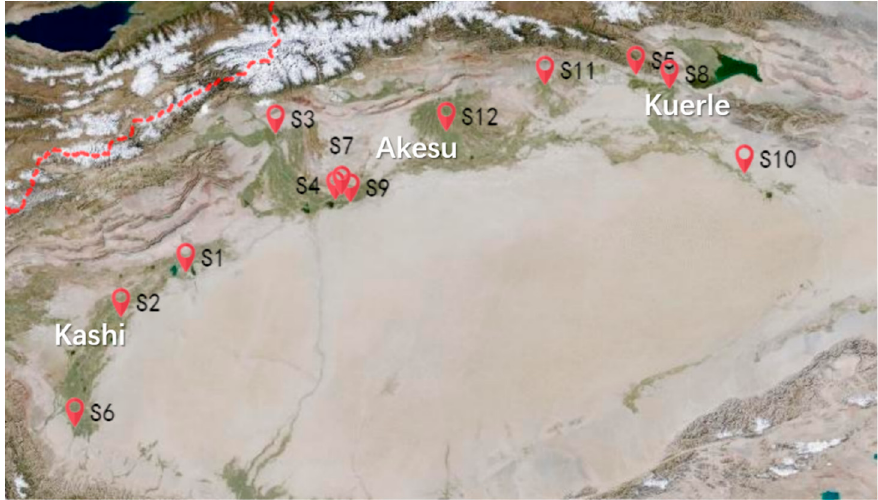
Figure 3. Geographic coordinates of the 12 pear orhchards in Xinjiang.